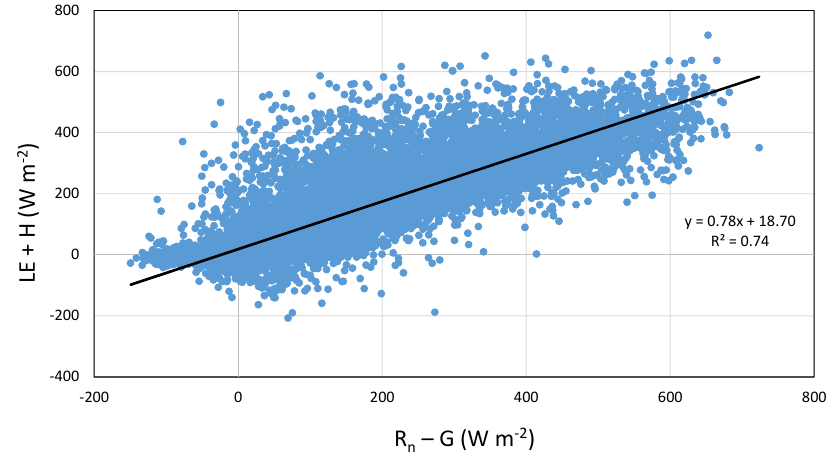
Figure 10. Surface energy closure in daytime in the Sundarbans mangroves during April 2012 to March 2013 with half-hourly fluxes. Soil heat flux includes energy storage between the surface and the 5 cm soil.